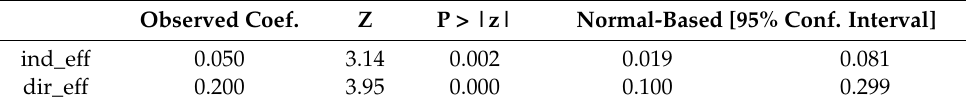
Table 8. Bootstrap mediation effect